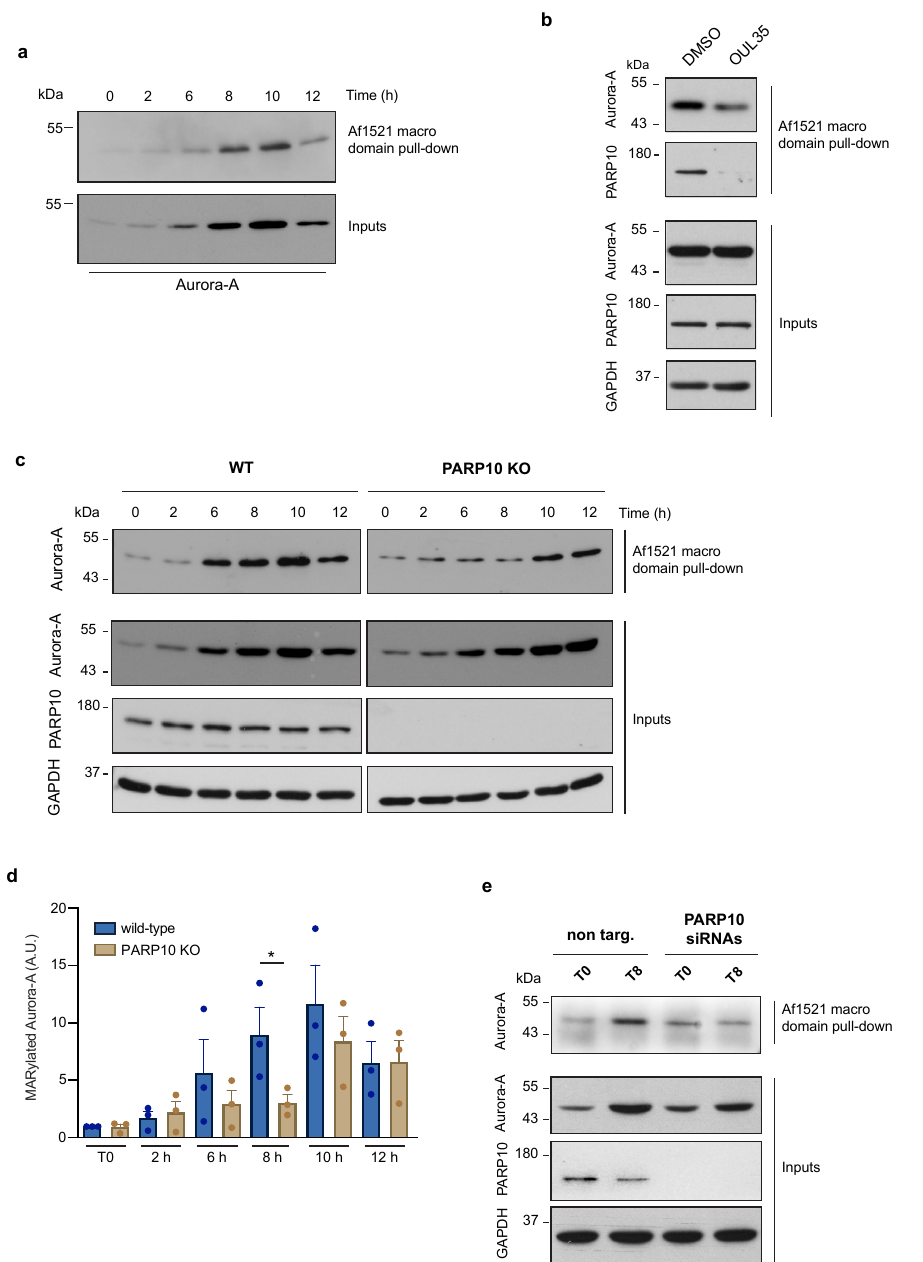
Figure 2. Aurora-A MARylation is dependent on PARP10 during the G2/M transition. MARylation levels of Aurora A were analyzed using the Af1521 macro domain-based pull-down assay on total cell lysates obtained from: ( a ) HeLa cells harvested at different time points (as indicated) after double thymidine block; ( b ) synchronized HeLa cells harvested at 8 h after release untreated (control) or treated with the PARP10 inhibitor OUL35 (10 µ M, 2 h); ( c ) wild-type and PARP10 KO HeLa cells harvested at different time points (as indicated) after double thymidine block; ( d ) Quantification of MARylated Aurora-A from c. Data are means ( ± S.D.) from three independent experiments. Two- tailed Student’s t-tests were applied to the data (* p < 0.05). ( e ) Total lysates from synchronized HeLa cells treated (48 h) with non-targeting siRNA (non-targ.) or a pool of PARP10 siRNAs (PARP10 siRNAs), were harvested at 8 h after release and analyzed for Aurora-A ADP-ribosylation by Af1521 macro domain-based pull-down assay. Full pictures of the Western blots are presented in Figure S6.